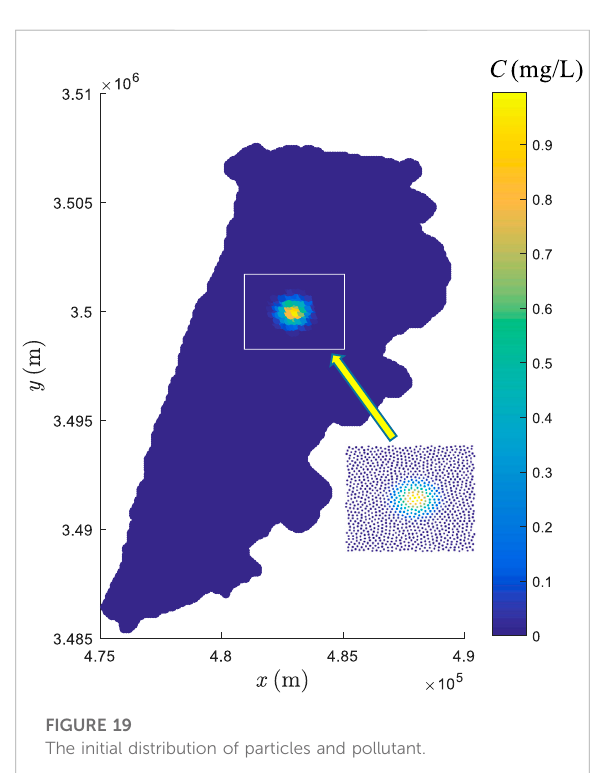
FIGURE 19 The initial distribution of particles and